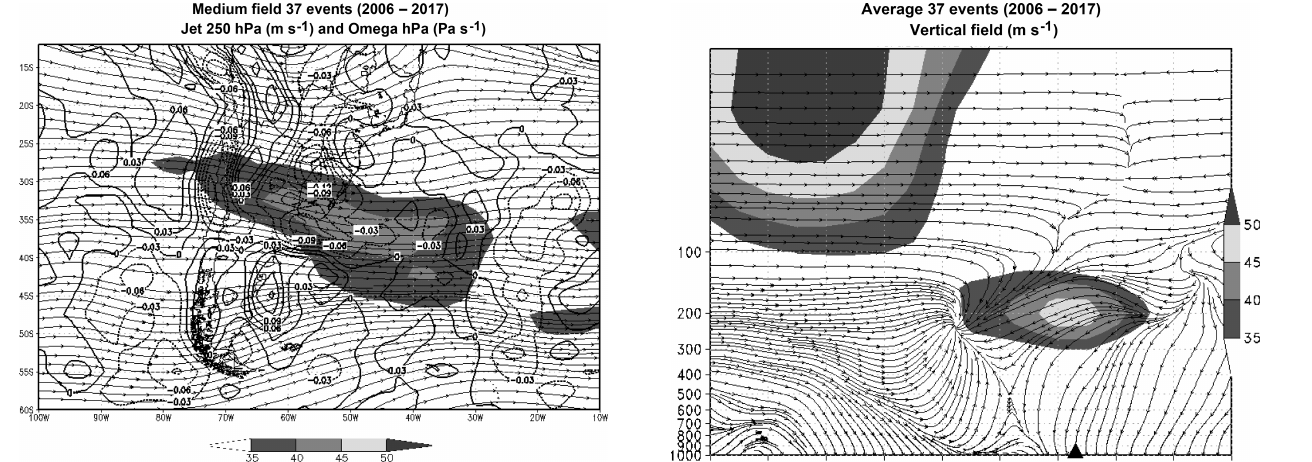
Figure 7. Average for the 37 events of the vertical field between 1000 and 30hPa, showing the jet current (shaded gray) in ms − 1